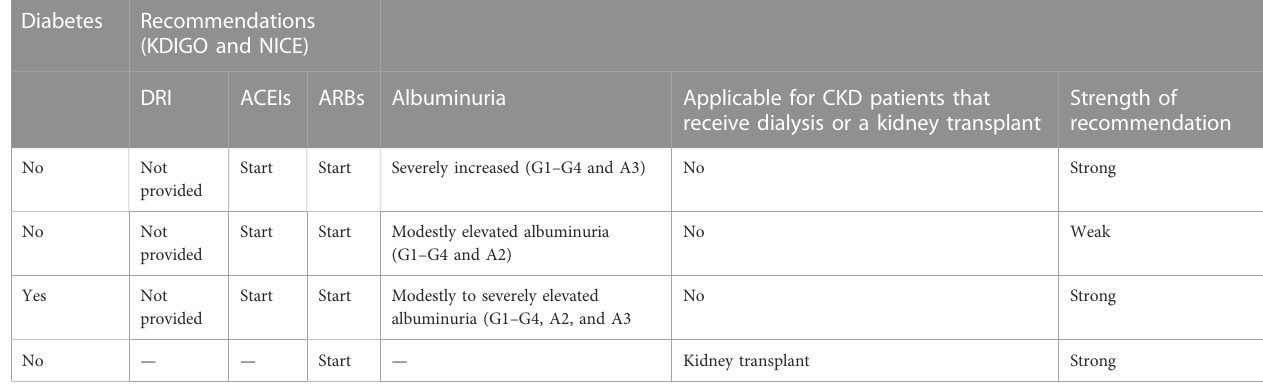
TABLE 3 Recommendations for the use of RAAS inhibitors for management of BP in CKD as per KDIGO and NICE.